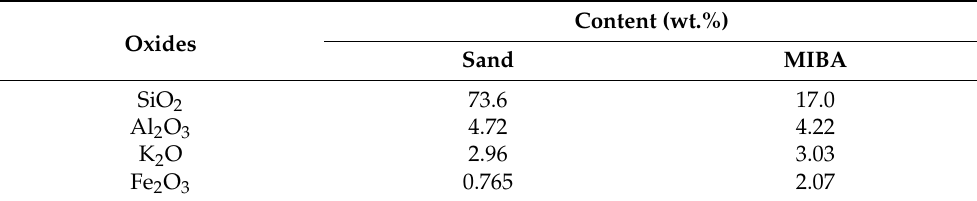
Table 2. Chemical composition of sand and MIBA.